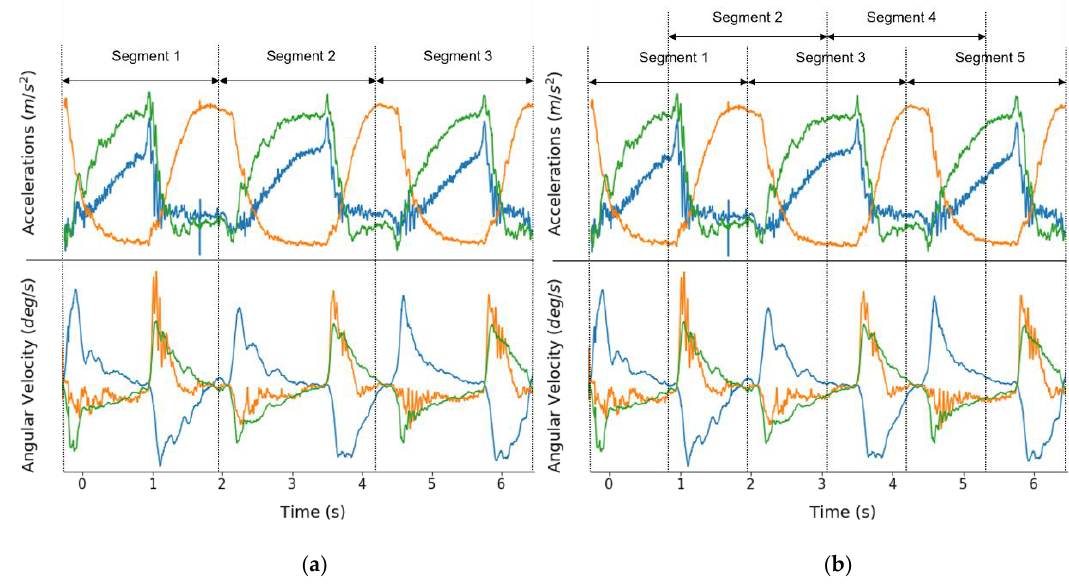
Figure 3. Two different segmentation schemes tested in this study: ( a ) nonoverlapping segmentation; ( b ) segmentation with 50% overlapping.